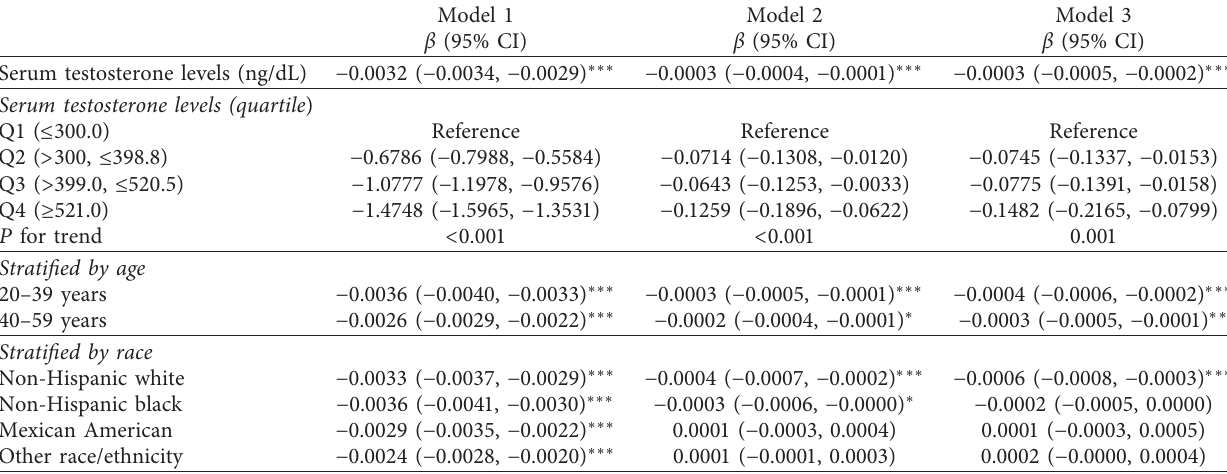
Table 4: Association between serum testosterone levels (ng/dL) and appendicular fat mass index (kg/m 2